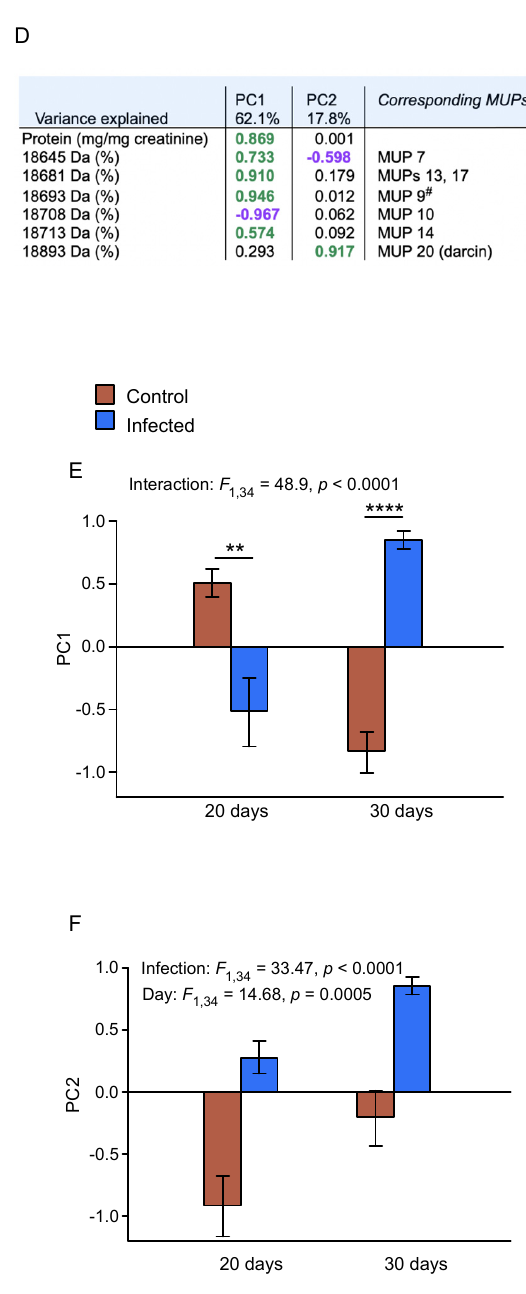
Figure 2. Changes in MUP output among adult males after acute LCMV v2.2 infection. Pairs of sib C57BL/6 males were singly housed at 8 weeks old and one male of each pair inoculated with v2.2 as previously described [31]. MUP output and profiles were analysed from urine samples taken at day 20 and day 30 post infection (N = 18 pairs per sample time point). Panel ( A ): total urinary protein output, corrected for urine dilution. Panels ( B ) and ( C ): amount of each major MUP peak expressed at day 20 or day 30 post infection, estimated from the total output and proportional area of each mass peak in the intact mass spectrum for each sample. Panels ( A – C ): plot medians, 25th, 75th percentiles, full range and individual data points. Panel ( D ): principal components analysis based on total protein output and proportion of each MUP mass, indicating loadings for each of the principal components derived (PC1 and PC2). Panels ( E ) and ( F ): PC1 and PC2 scores for infected and control males at day 20 and day 30 post-infection (mean ± s.e.m.). MUP9 # refers to the group of central MUPs of very similar or identical mass (see Figure 1). * p < 0.05, ** p < 0.01, **** p < 0.0001. Sequential Bonferroni correction was applied to analyses in panels ( B ) and ( C ) to correct for comparison of multiple MUP